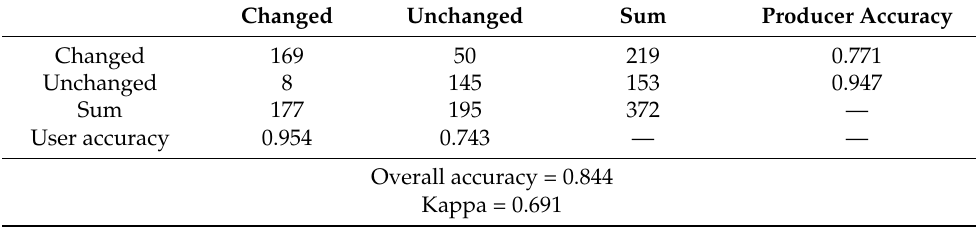
Figure 16. Change detection results based on cosegmentation for ( a ) GF-1 and ( b ) Landsat imagery. Table 6. Accuracy of GF-1 imagery change detection results based on cosegmentation.